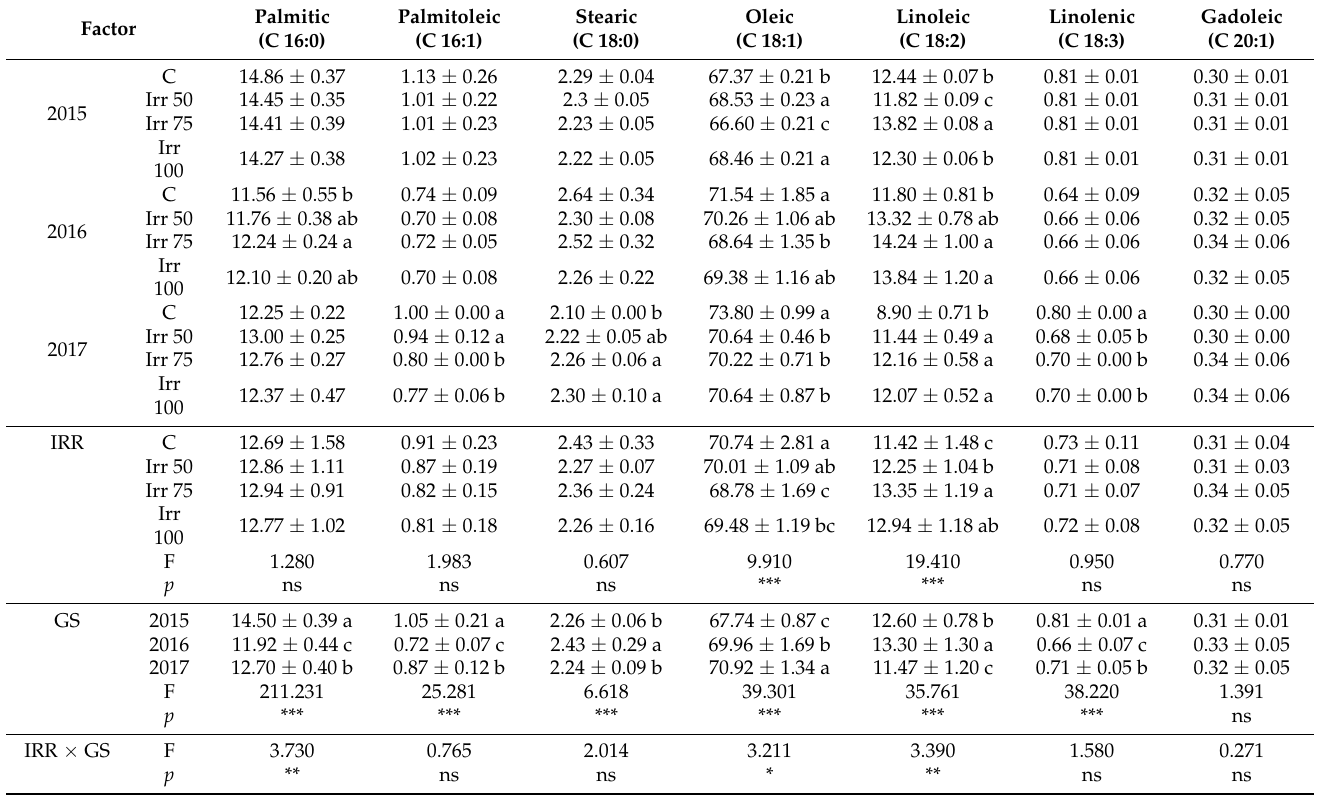
Table 6. Effect of different irrigation levels on fatty acid composition in virgin olive oils in three experimental